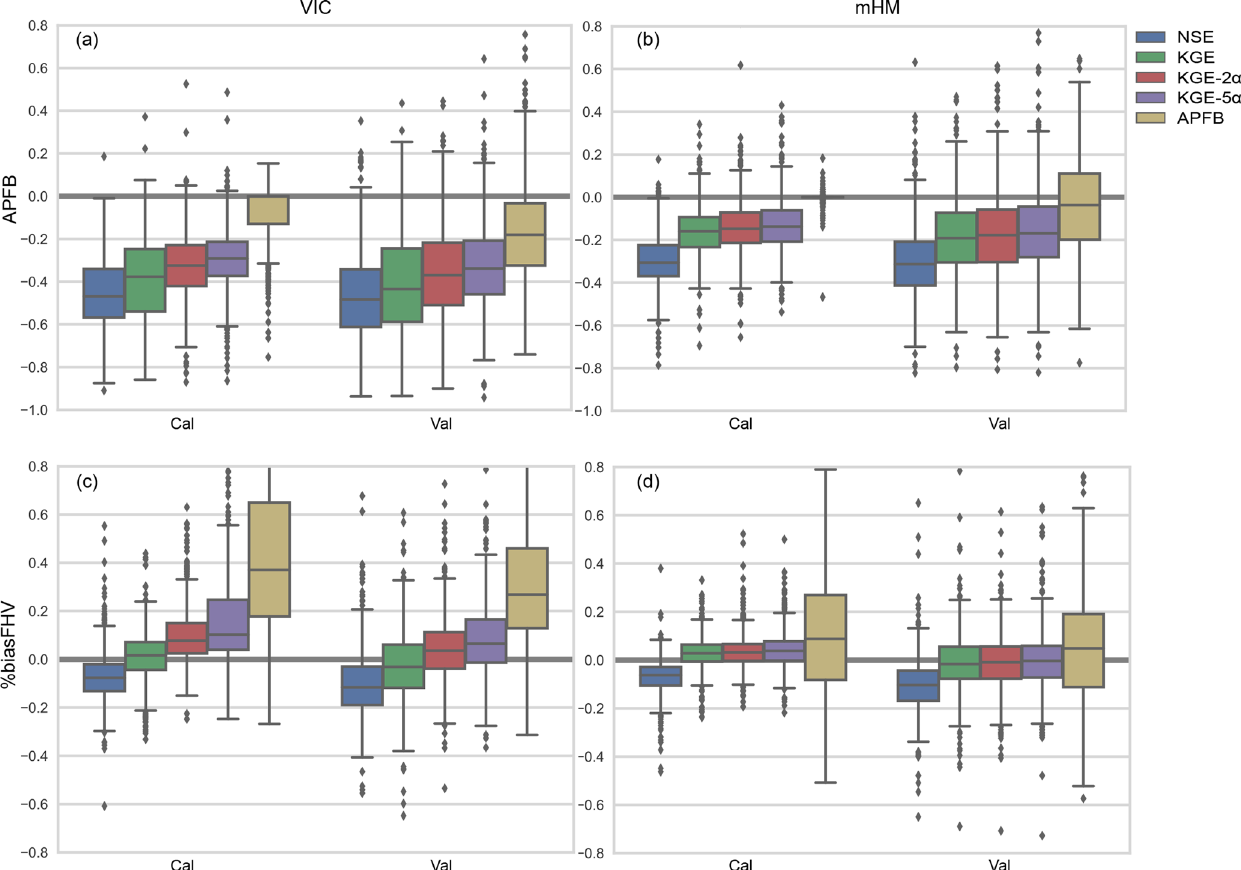
Figure 4. Boxplots of percent bias of APFB ( a , b ) and flow volume above the 80th percentile flow duration curve (%biasFHV: c , d ) over the 492 HCDN basin calibrations with five performance metrics for calibration and evaluation periods and two models. Box width represents the inter-quartile range (first and third quartiles), and lower and upper whiskers are placed at 1.5 times the inter-quartile range.